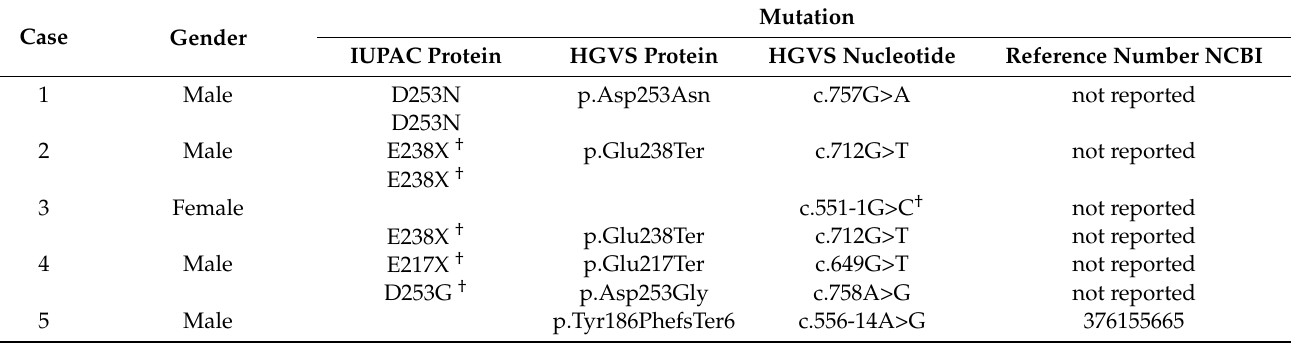
Table 4. Molecular analysis of patients with congenital tufting enteropathy included in the present